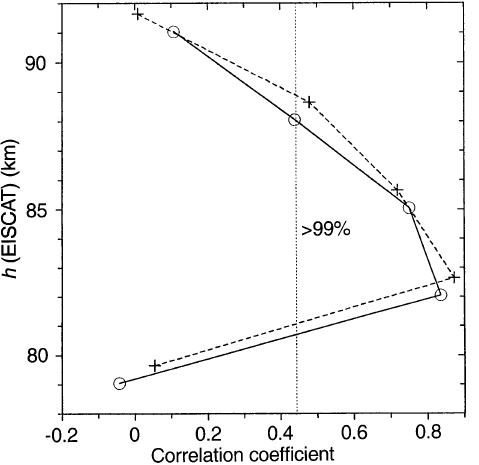
Fig. 4. Correlation between hourly SNR values obtained by EISCAT and ALOMAR SOUSY observations as a function of height using SNR values at equal heights ( solid lines ) and at different heights ( dashed line : h (EISCAT) " h (ALOMAR SOUSY) # 0.4